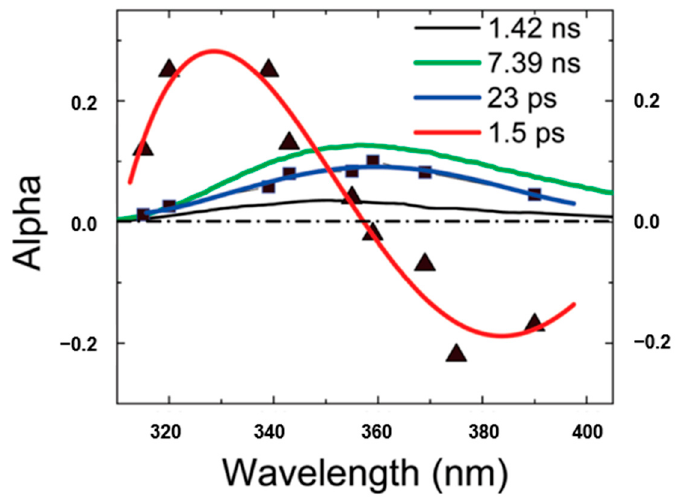
Figure 8 Figure 8. Decay associated spectra of Trp-leu in water. Image reproduced from Journal of Physical